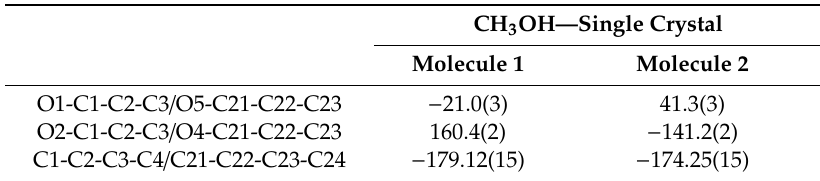
Table 1. Torsion angles (°) indicating the different conformation of the carboxylic groups with respect to the alkyl chains.